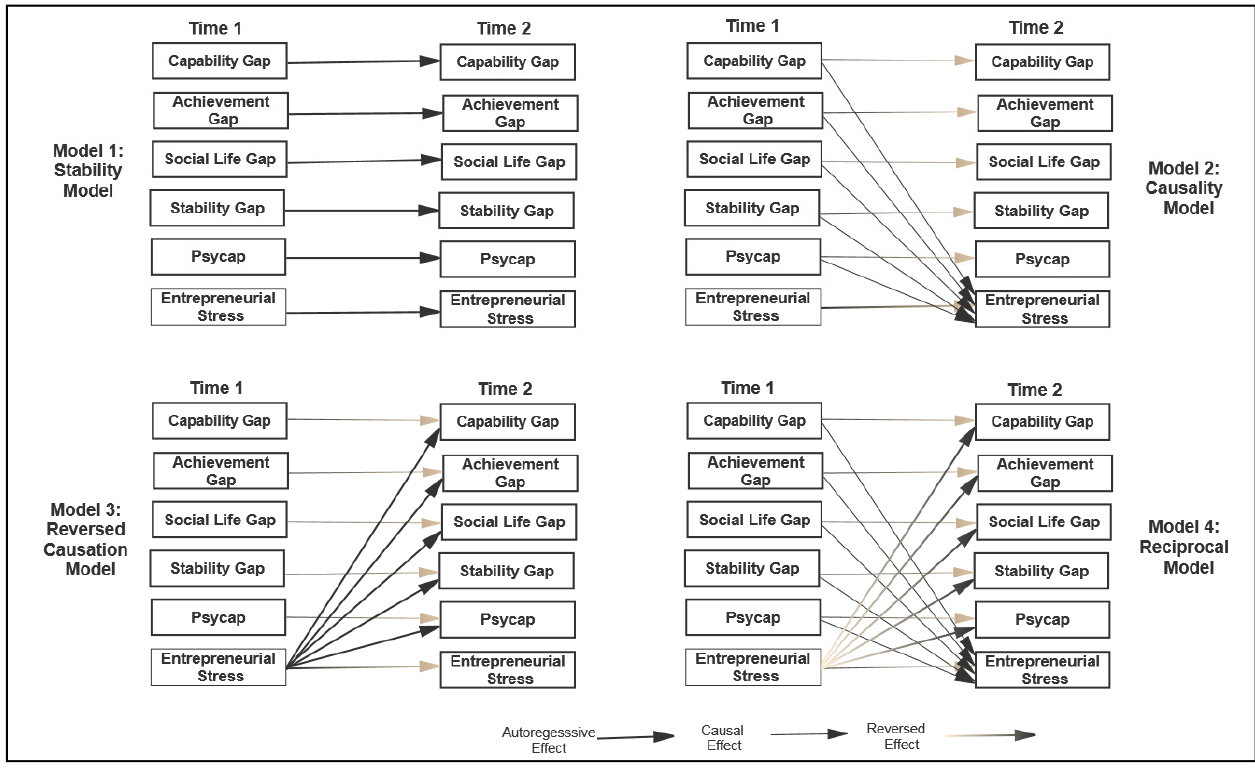
Figure 1. Competing Models.